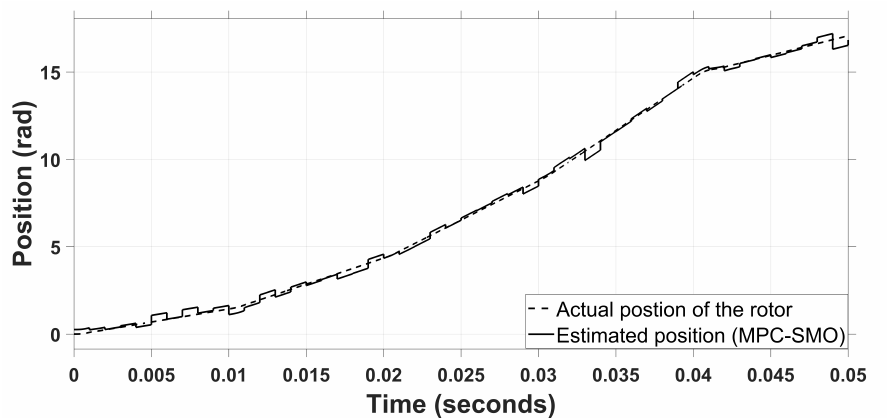
Figure 15. Position estimation with